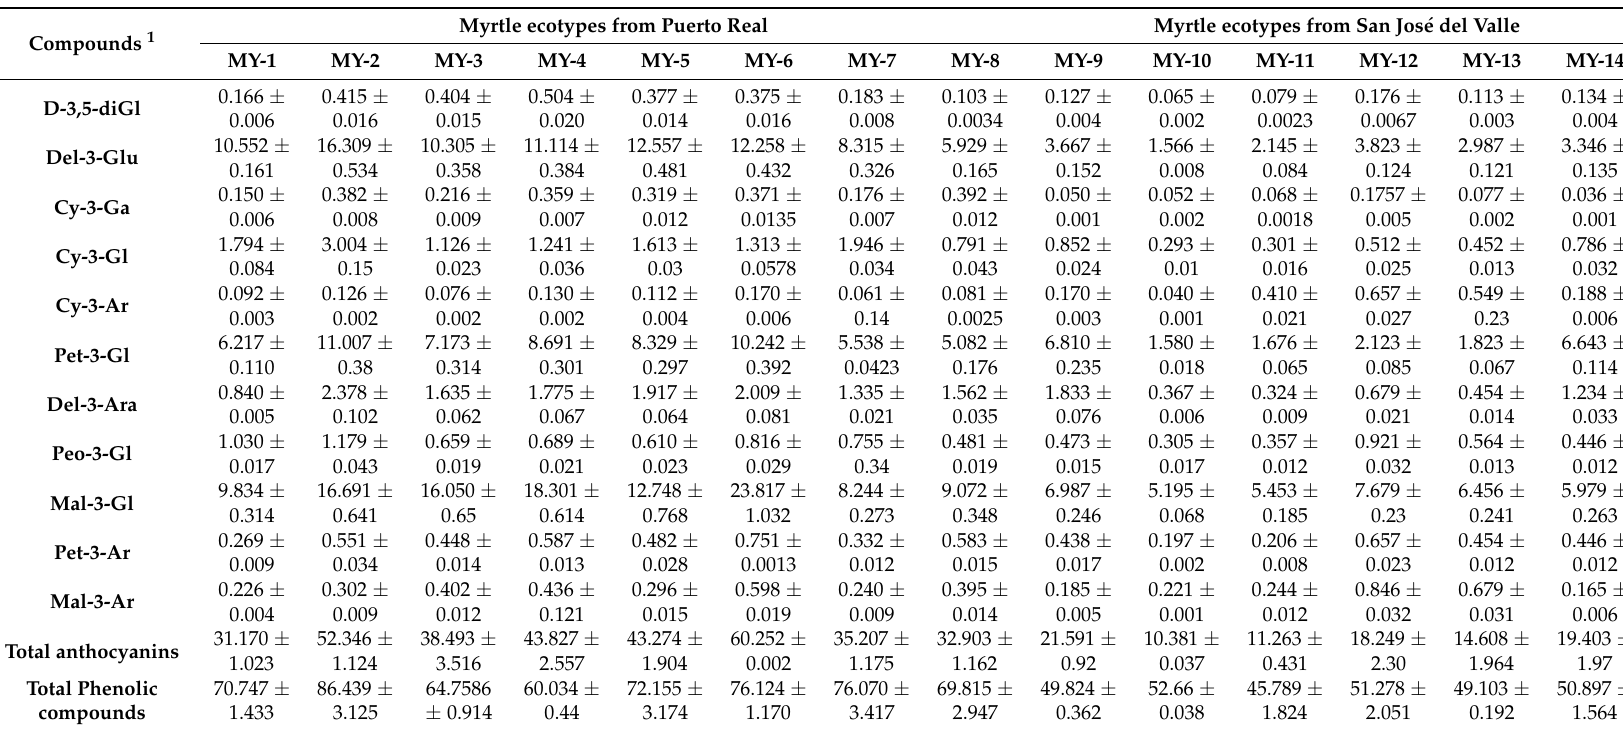
Table 4. Extract concentrations (mg · g − 1 ) of total anthocyanins and total phenolic compounds ( n = 3) obtained from different myrtle ecotypes by means of ultrasound-assisted method